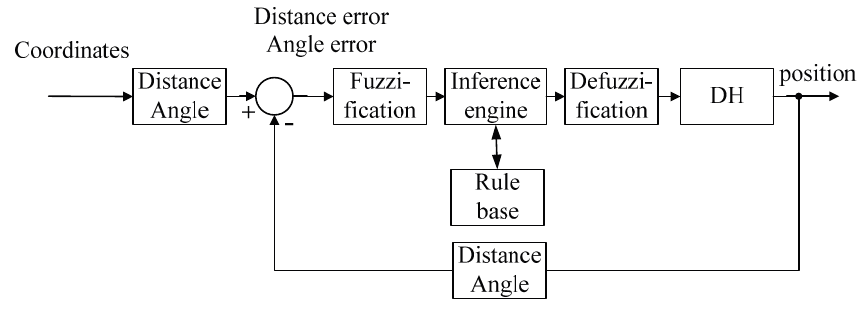
Figure 26. Fuzzy control scheme.